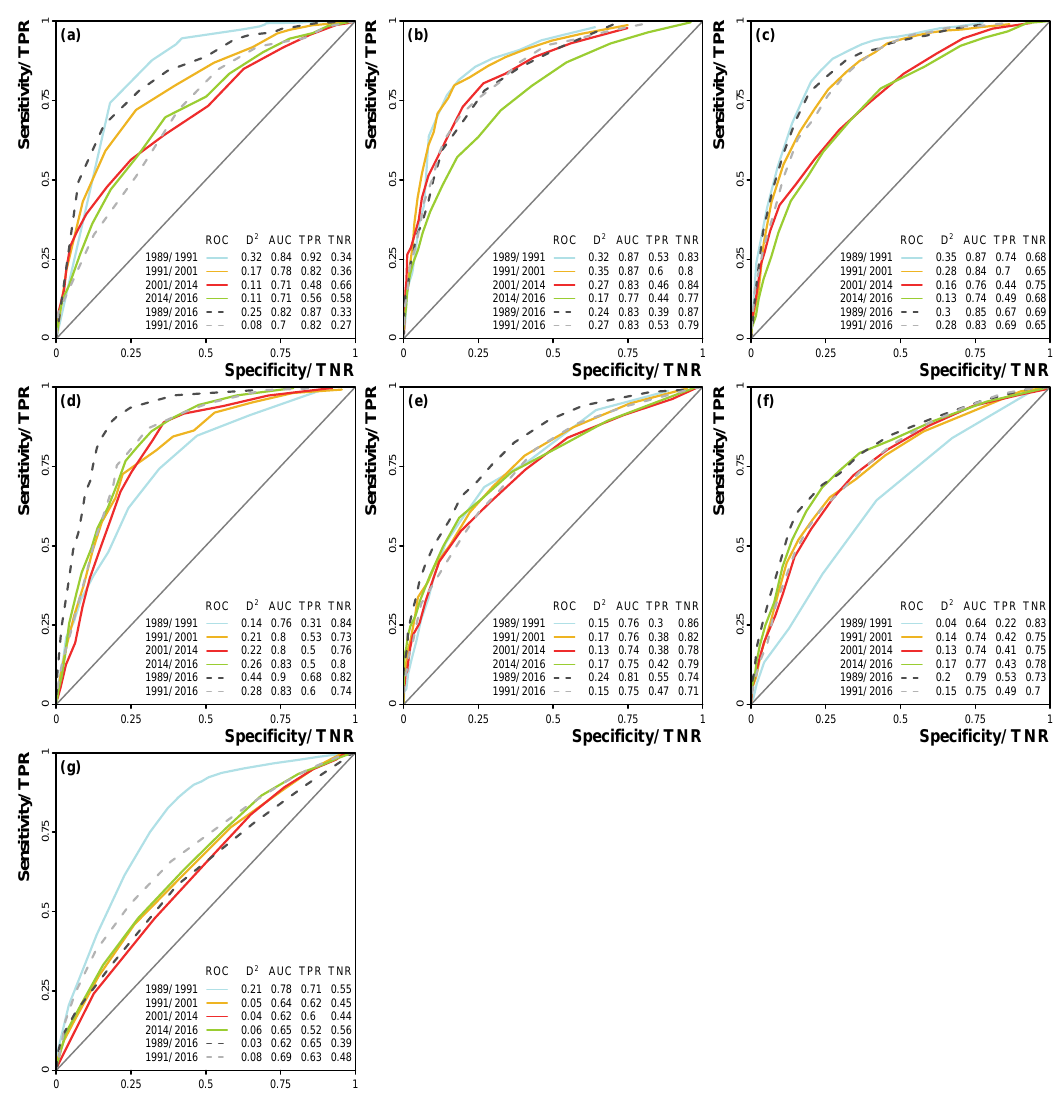
Figure 7. Receiver Operating Characteristic (ROC) curves for regression analyses results of ( a ) GHBG, ( b ) Settlement, ( c ) combined GHBG and Settlement, ( d ) Natural Vegetation 1, ( e ) Natural Vegetation